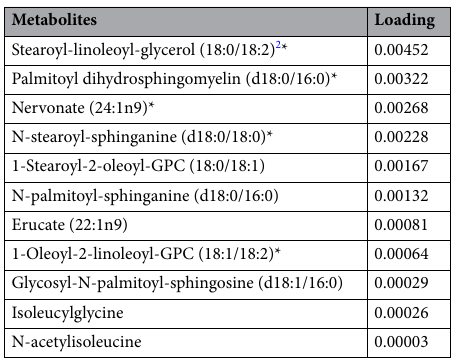
Table 3. List of 11 metabolites composing IPC4, associated with sPTB.